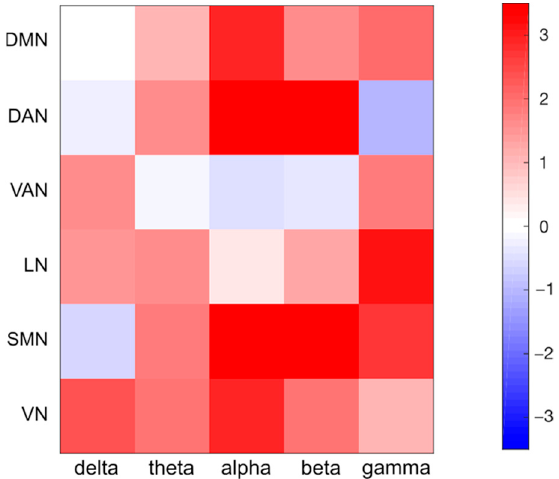
Figure 5. Intra- and inter-network connectivity differences per network and frequency band. A comparison was performed by means of a Wilcoxon signed-rank paired test; the color bar represents the z-value obtained through the test, where the red colors stand for intra-network connectivity values higher than inter-network ones, and the blue colors vice-versa.